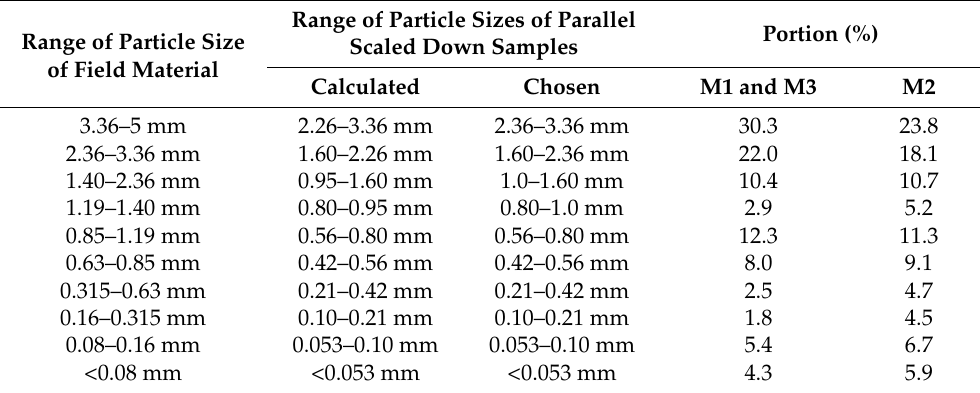
Table 2. Calculation and selection of particle sizes for making parallel scaled samples with d max = 3.36 mm for field samples M1, M2 and M3.